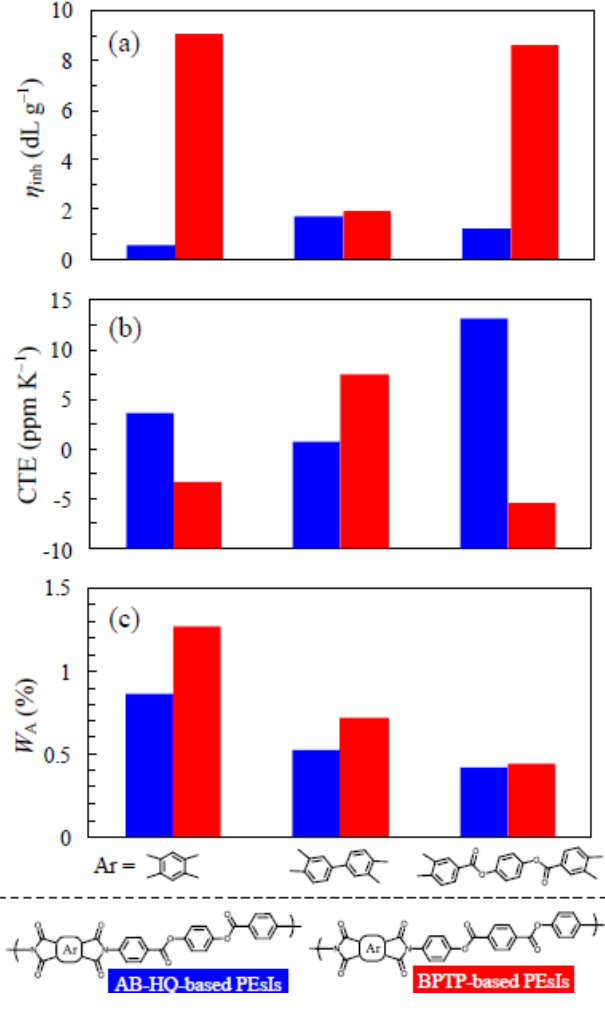
Figure 6. Comparisons of the properties for the AB-HQ-based (left/blue bar) and BPTP-based systems (right/red bar): ( a ) η inh of PAAs, ( b ) CTE, and ( c ) water uptake of the PEsI films.